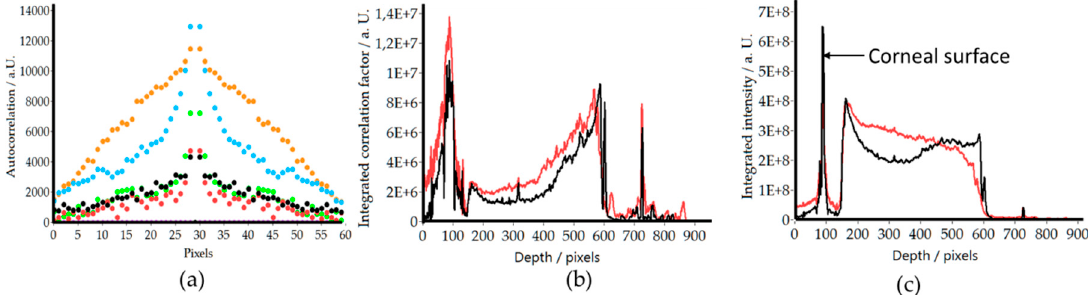
Figure 6. Quantitative evaluation of stromal structure observed in the cross polarized channel. ( a ) Central horizontal autocorrelation function retrieved from en-face images. Black, red, green, blue and orange correspond to an imaging depth of 100, 200, 300, 400, 500 pixels (101, 202, 303, 404, 505 µm) from the corneal surface, respectively. Purple corresponds to the autocorrelation function of residual noise (800 pixel depth); ( b ) Integrated autocorrelation coefficient (IACF) in dependence of imaging depth (the corneal surface is located at pixel 90); ( c ) Integrated intensity in dependence of imaging depth. Black subject 1, red subject 2.